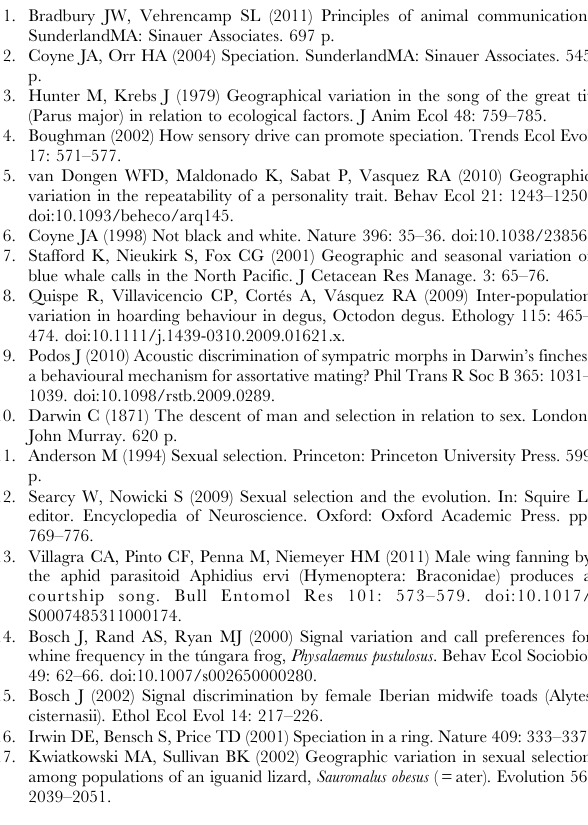
Figure S3 EVR variables measured for males from Osorno to four stimuli series. Name of the stimuli series (Standard, Dominant frequency, Pulse rate and Modulation depth) are indicated at the bottom of the figure. The values of each variant within a stimulation series are shown in the abscissa. Stimuli order corresponds to presentation order 1 (see text). Abbreviations: T, LM and O: standard calls of Totoral, Los Maitenes and Osorno, respectively. Filled circles and bars represent averages and standard errors, respectively.